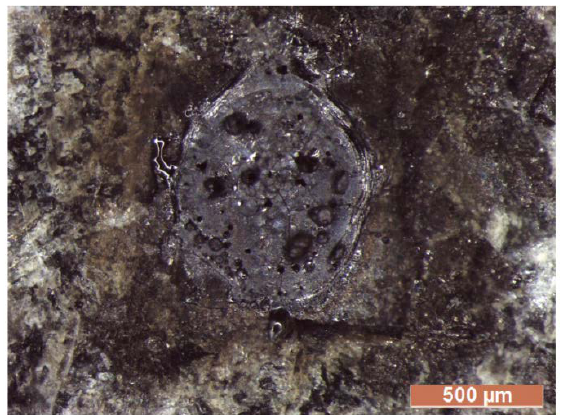
Figure 10. Optical microscopy images of bubbles in fulgurite glass of wet sample A3. These bubbles can be generated from the vaporization of water and incorporation of air during the fast cooling of rock melt on the wet sample surface.